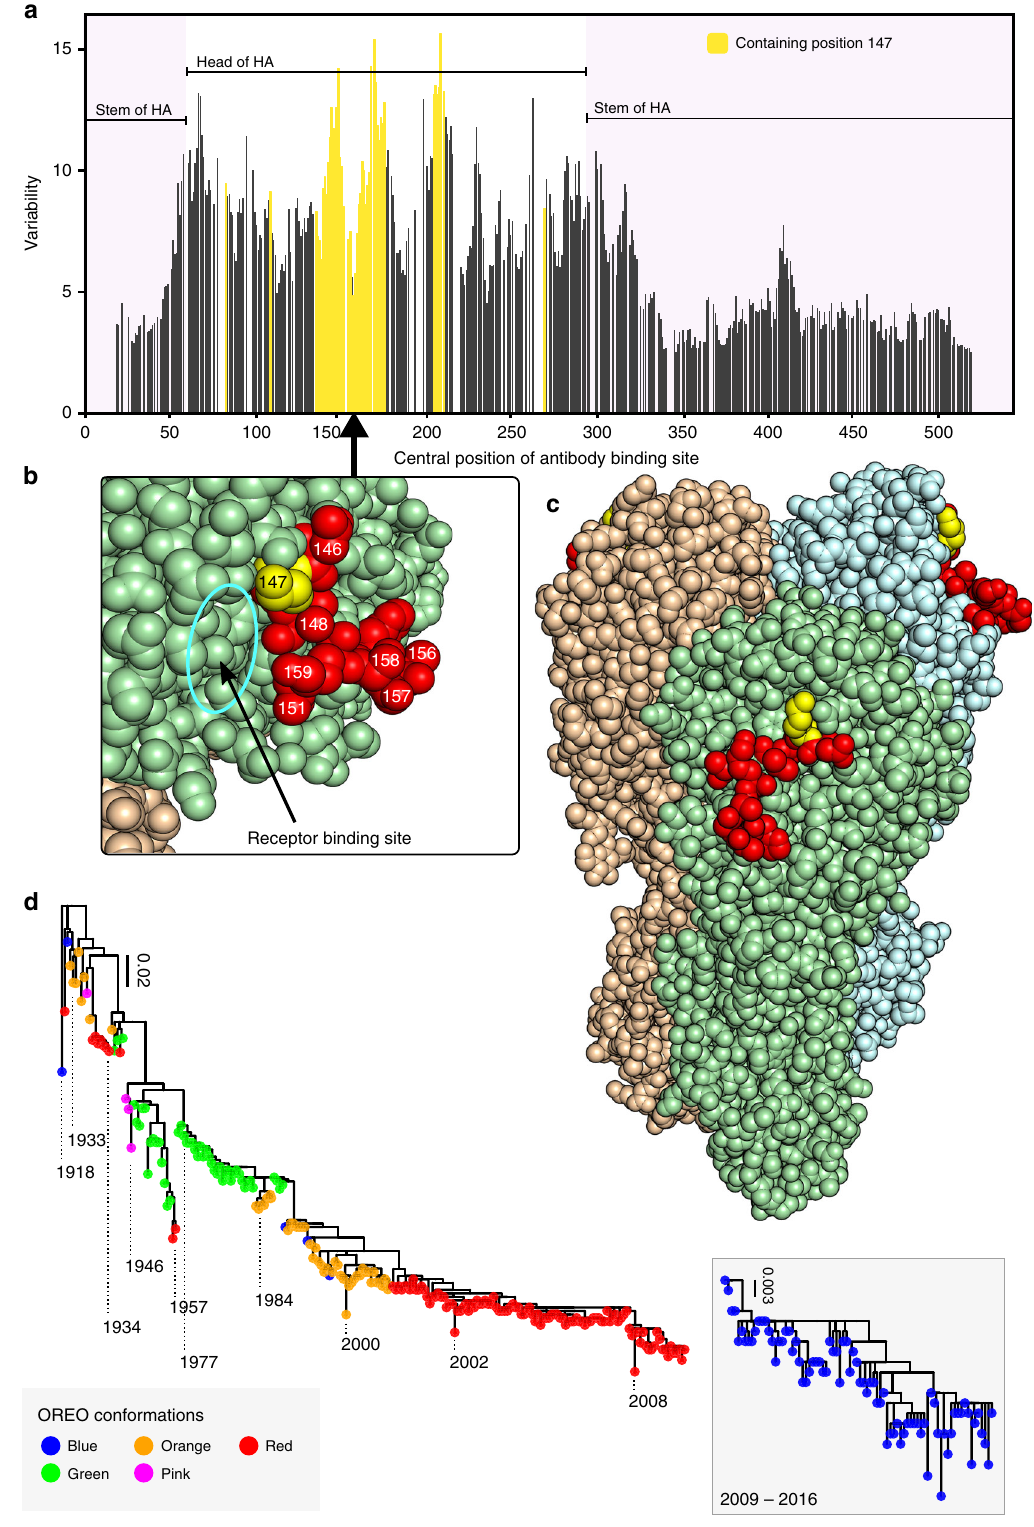
Fig. 2 Identi fi cation of a site of limited variability in the head domain of the H1 HA. a Variability of antibody bindings sites (ABSs) on the crystal structure of A/California/04/2009 HA; those containing position 147 are shown in yellow. b , c Location of ABS of lowest variability containing position 147 with position 147 shown in yellow and the rest of the site coloured in red. d Phylogenetic trees of pre-pandemic and post-pandemic highlighted rectangle H1N1 with tips coloured according to the conformation of the epitope of limited variability (hereafter called OREO). Please note the re-introduction of H1N1 in fl uenza in 1977 involved a strain which previously circulated in 1949/50 39,